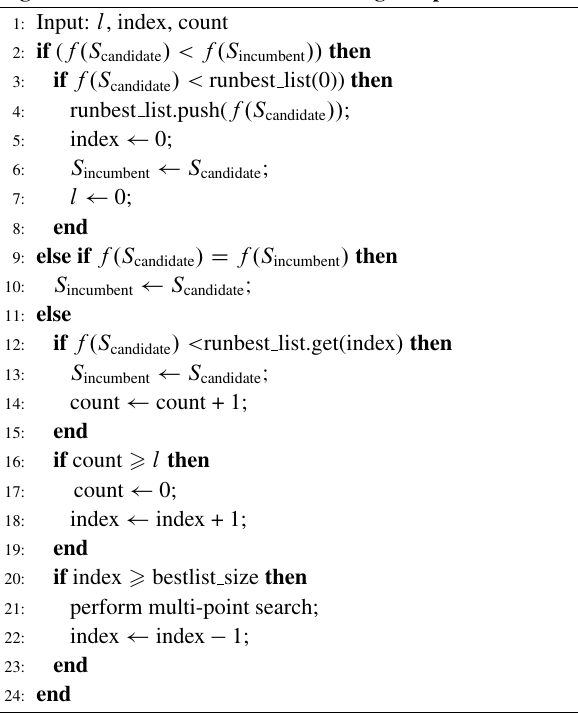
Algorithm 3 Pseudocode of the moving